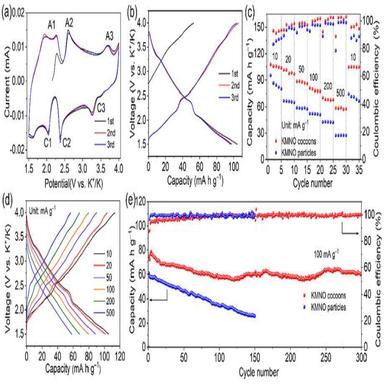
(a) CV curves and (b) galvanostatic charge/discharge curves at 20 mA g1 of the KMNO cocoons. (c) Rate properties of the KMNO cocoons and KMNO particles and the relevant Columbic efficiencies. (d) Galvanostatic charge/discharge profiles of the KMNO cocoons at various current densities. (e) Long-term cyclic performance of the KMNO cocoons and the KMNO particles at 100 mA g1 and the concerned Columbic efficiencies.